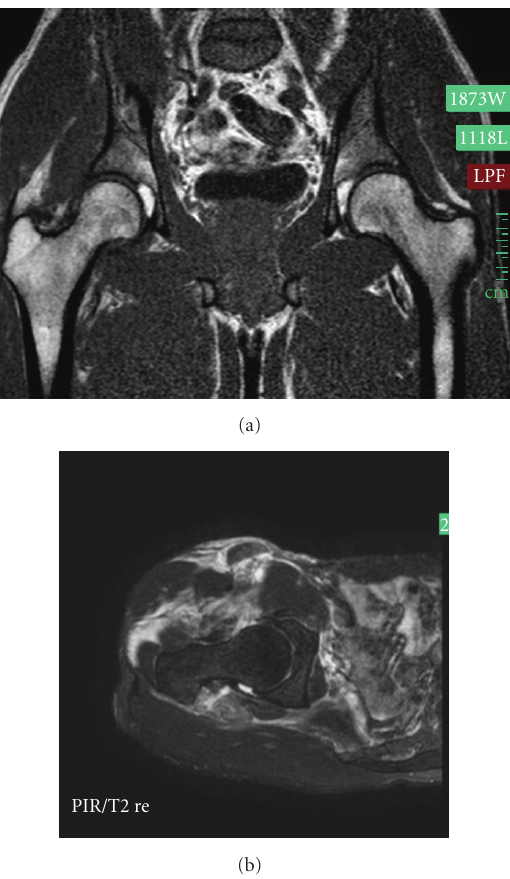
Figure 3: MRI of both hips (a) and transverse cut of the right hip (b) shows no e ff usion of the congruent right hip, but swelling of the right pelvic